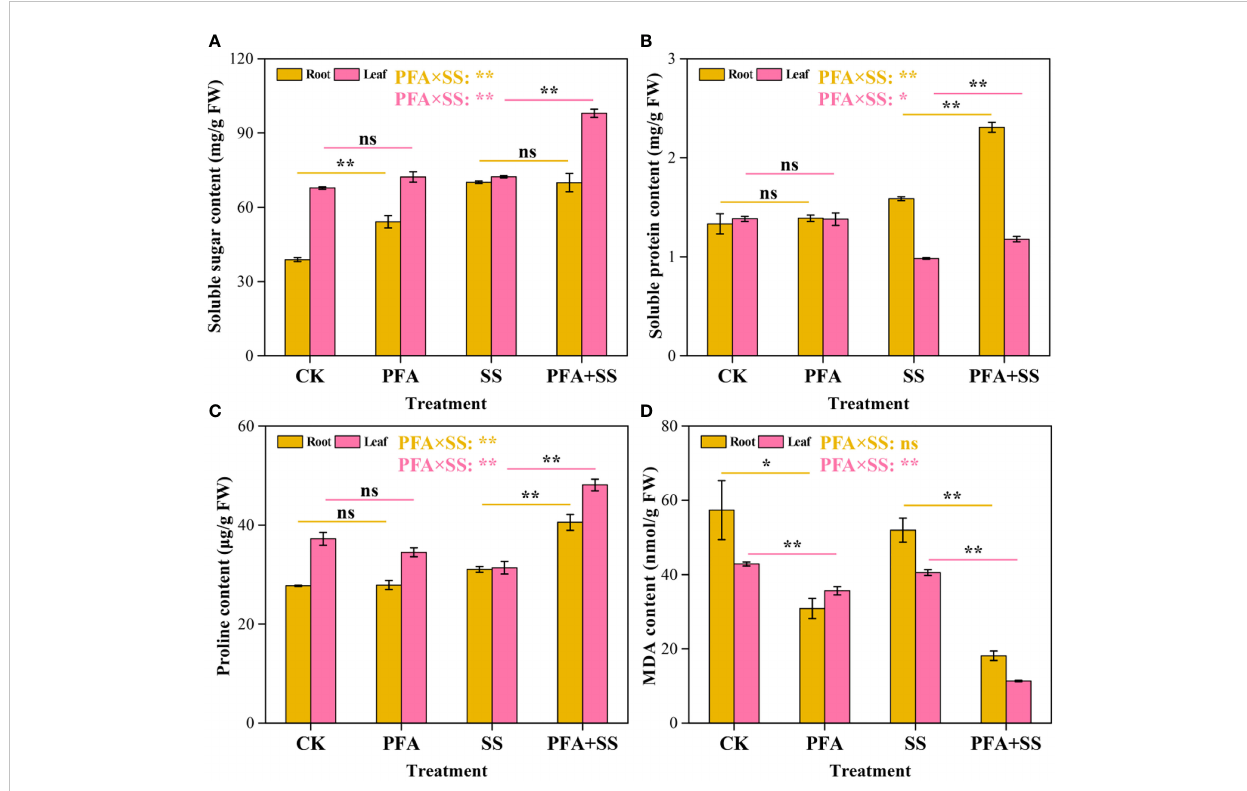
FIGURE 3 The contents of soluble sugar (A) , soluble protein (B) , proline (C) and MDA (D) in the seedlings. CK, the seedlings without PFA and salt stress; PFA, the seedlings amended with PFA and without salt stress; SS, the seedlings with salt stress; PFA+SS, the seedlings amended with both PFA and salt stress. PFA × SS, interaction between PFA and SS. The error bars represent the standard error (n = 3). “ ns ” , “ * ” , and “ ** ” mean not signi fi cant, p < 0.05 and p < 0.01 according to Student ’ s t test and two-way ANOVA,